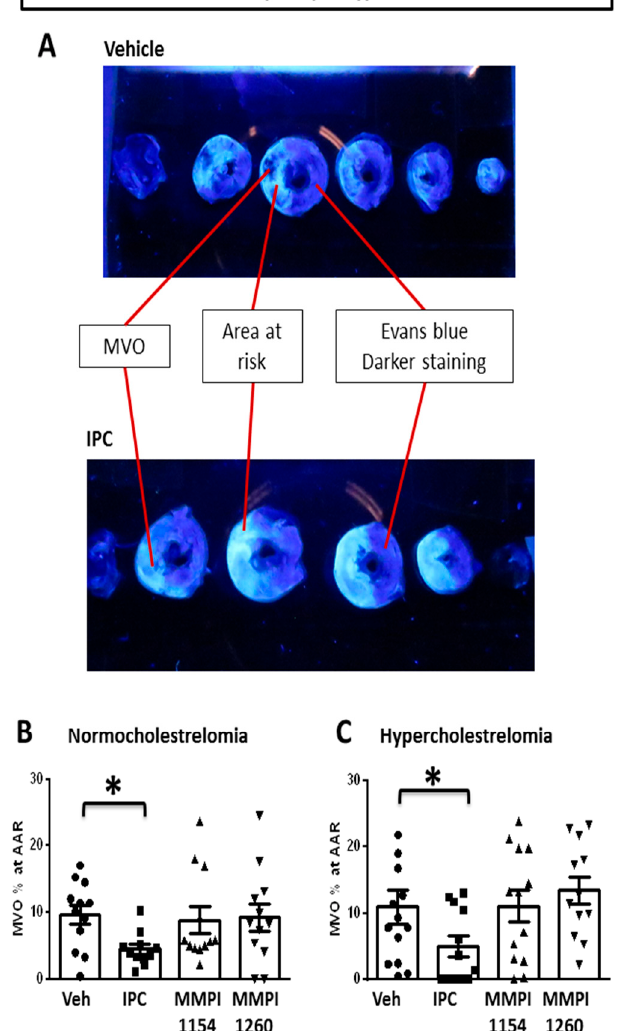
Figure 6. Microvascular obstruction (MVO) in rat heart after myocardial ischemia/reperfusion injury. ( A ) Representative image of MVO in Vehicle-treated group and IPC group. The effects of IPC and MMP inhibitors on MVO in ( B ) age-matched normocholesterolemic and ( C ) hypercholesterolemic rats subjected to in vivo 30-min coronary occlusion followed by 120 min reperfusion. Veh: dimethyl sulfoxide, IPC: ischemic preconditioning. One-way ANOVA followed by Fisher’s LSD post-hoc test, n = 14–16, data are expressed as means ± SEM, * p < 0.05.